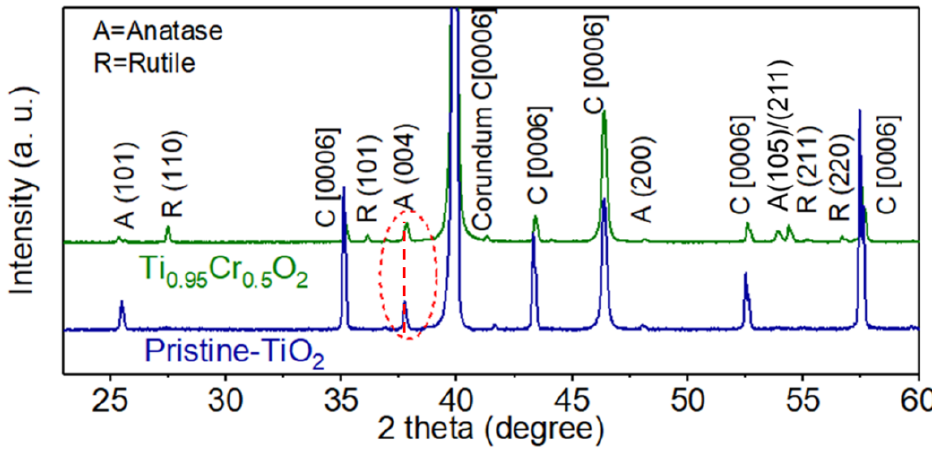
Figure 2. The X-ray diffractograms of the pristine TiO 2 -sensing layer and Ti 0.95 Cr 0.5 O 2 -sensing layer deposited on corundum [0006] substrate and annealed at 800 ° C.